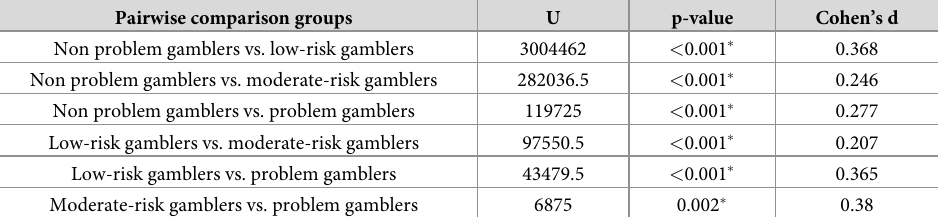
Table 2. Pairwise comparisons of the effects of problem gambling on loot box spending. Effects that are significant at the p < 0.008 level are marked with a � . Pairwise comparison groups